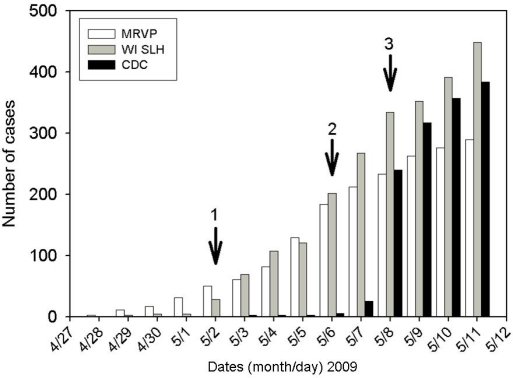
Cases of S-OIV reported in Wisconsin as enumerated by MRVP, WI SLH and CDC surveillance by calendar day during first 2 weeks of the S-OIV epidemic. Arrow 1: Cases reported by MRVP were validated to be “probable” S-OIV by WI SLH. MRVP cases were then included automatically in SLH totals. Arrow 2: Cases reported by MRVP were validated as “confirmed” by WI SLH using the CDC assay. MRVP and SLH cases were then included automatically in CDC totals. Arrow 3: testing is restricted to high risk patients. Note that the MRVP samples only come from southeastern Wisconsin, while the WI SLH cases include reporting from throughout the state.